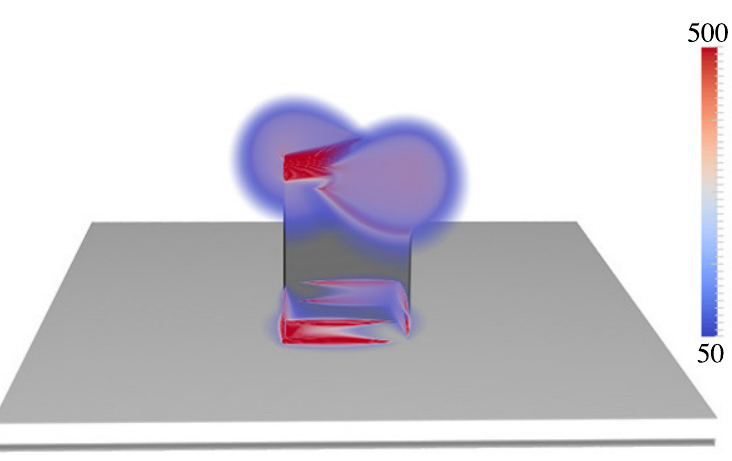
Figure 7. Plot of electric field intensity enhancement ( g 2 = | E | 2 / | E 0 | 2 ) at λ = 785 nm for optimized square NP. The optimal parameters are D = 150 nm, RD = 190 nm, P = 730 nm, and MT = 24 nm with an O . F . = 6.3. Only enhancements in the 50–500 range are plotted.